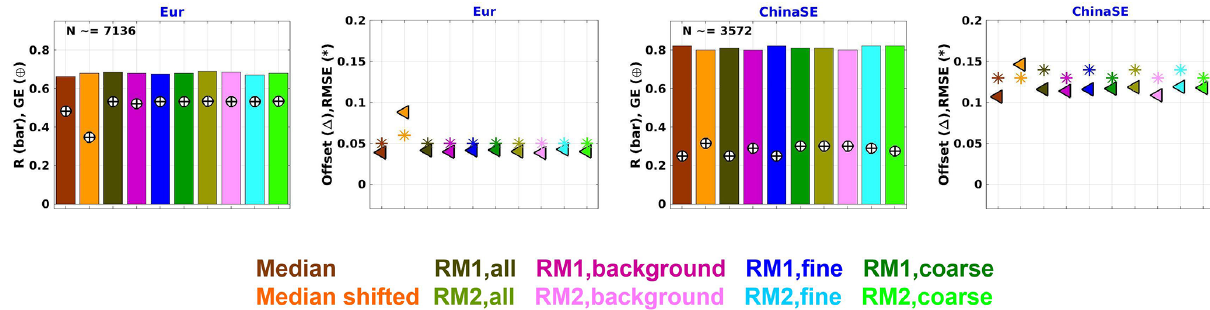
Figure 8. AERONET comparison statistics: correlation coefficient R , bar, and fraction of pixels satisfying the GCOS requirements, GE, ⊕ ; offset, (cid:49) , and root-mean-square error RMSE, *. Shown for AOD products merged with different approaches, median, shifted median, RM1 and RM2 for different aerosol types for Europe and ChinaSE. For all regions, see Fig.